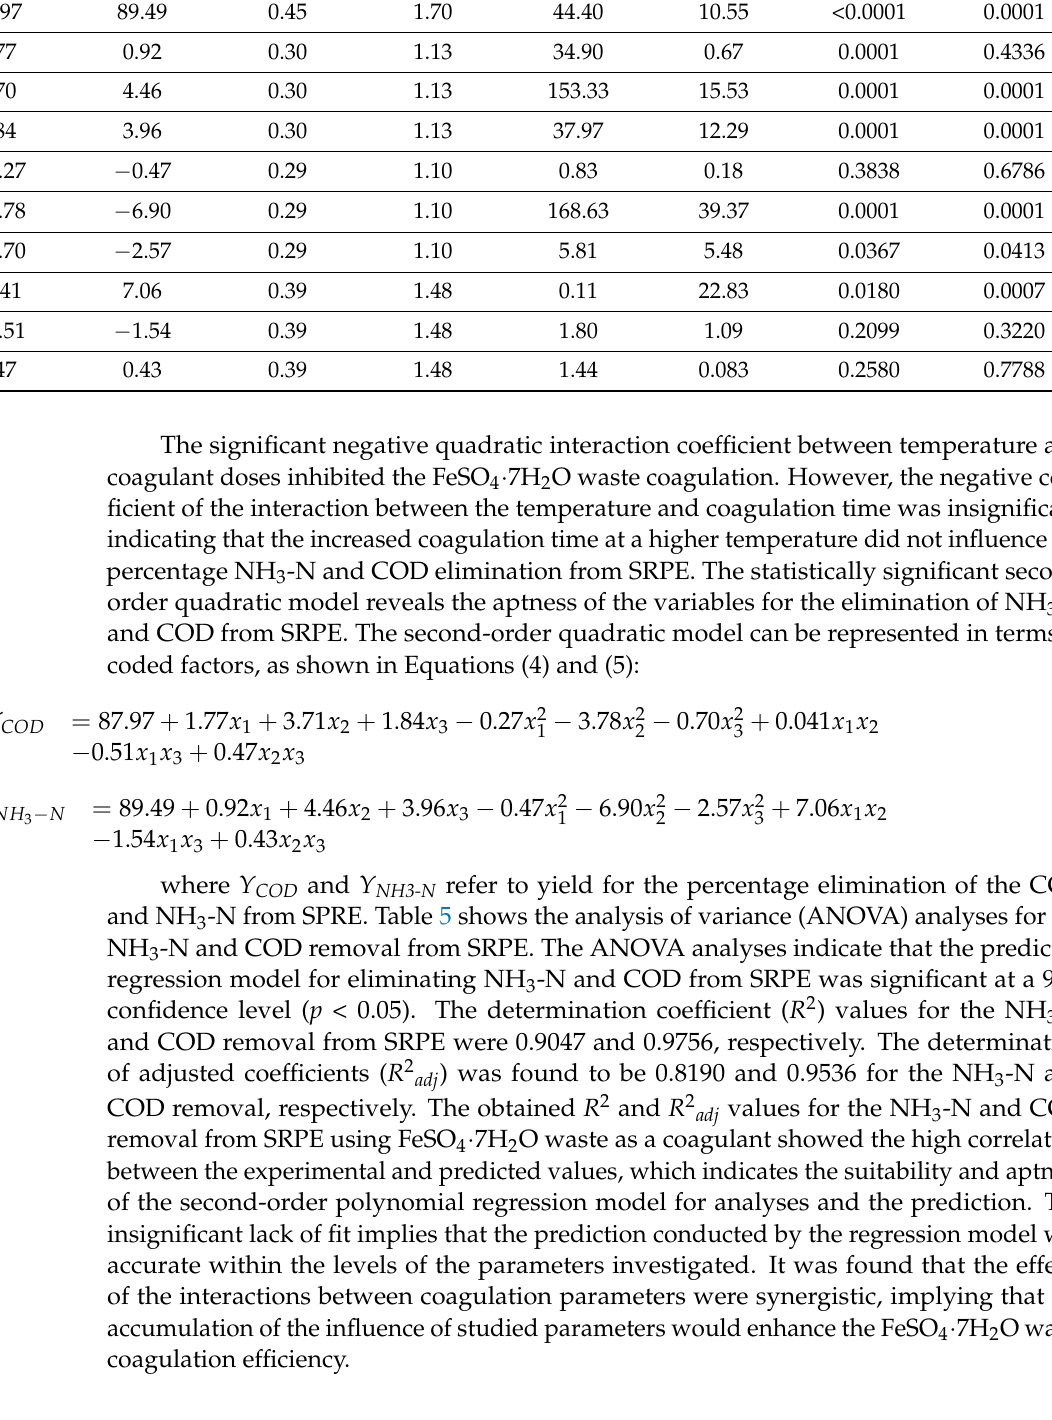
Table 4. Regression Coefficient from Linear and Quadratic Model for the Removal of COD and NH 3 -N from SRPE using FeSO 4 · 7H 2 O waste as a coagulant. Coefficient Term